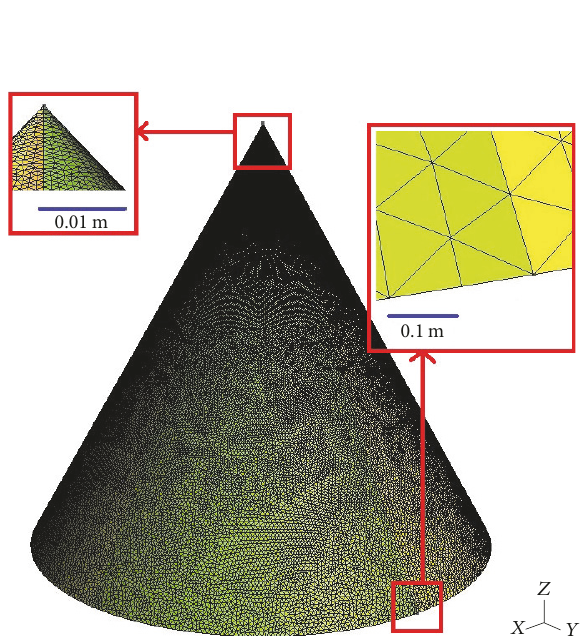
Figure 7: A cone of radius 5 m and height 10 m, which is meshed with average length 0.1 m at the bottom and 0.001 m at the sharp point. Mesh details are shown with reference lengths 0.1m and 0.01